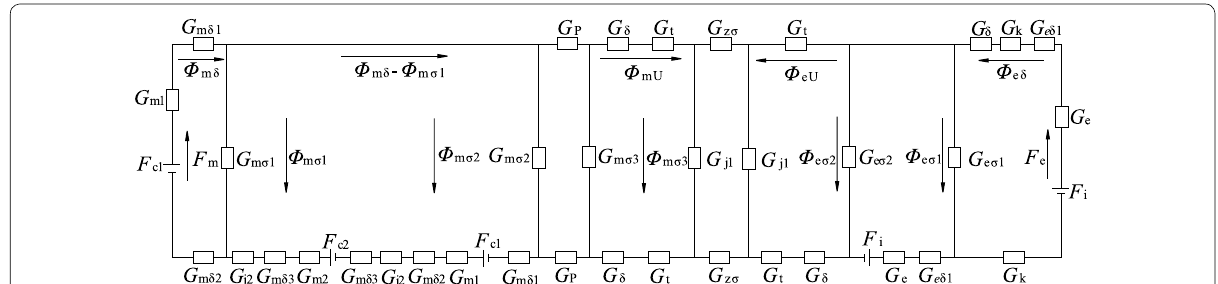
Figure 9 The equivalent magnetic circuit diagram of double-radial permanent magnet and salient-pole electromagnetic hybrid excitation